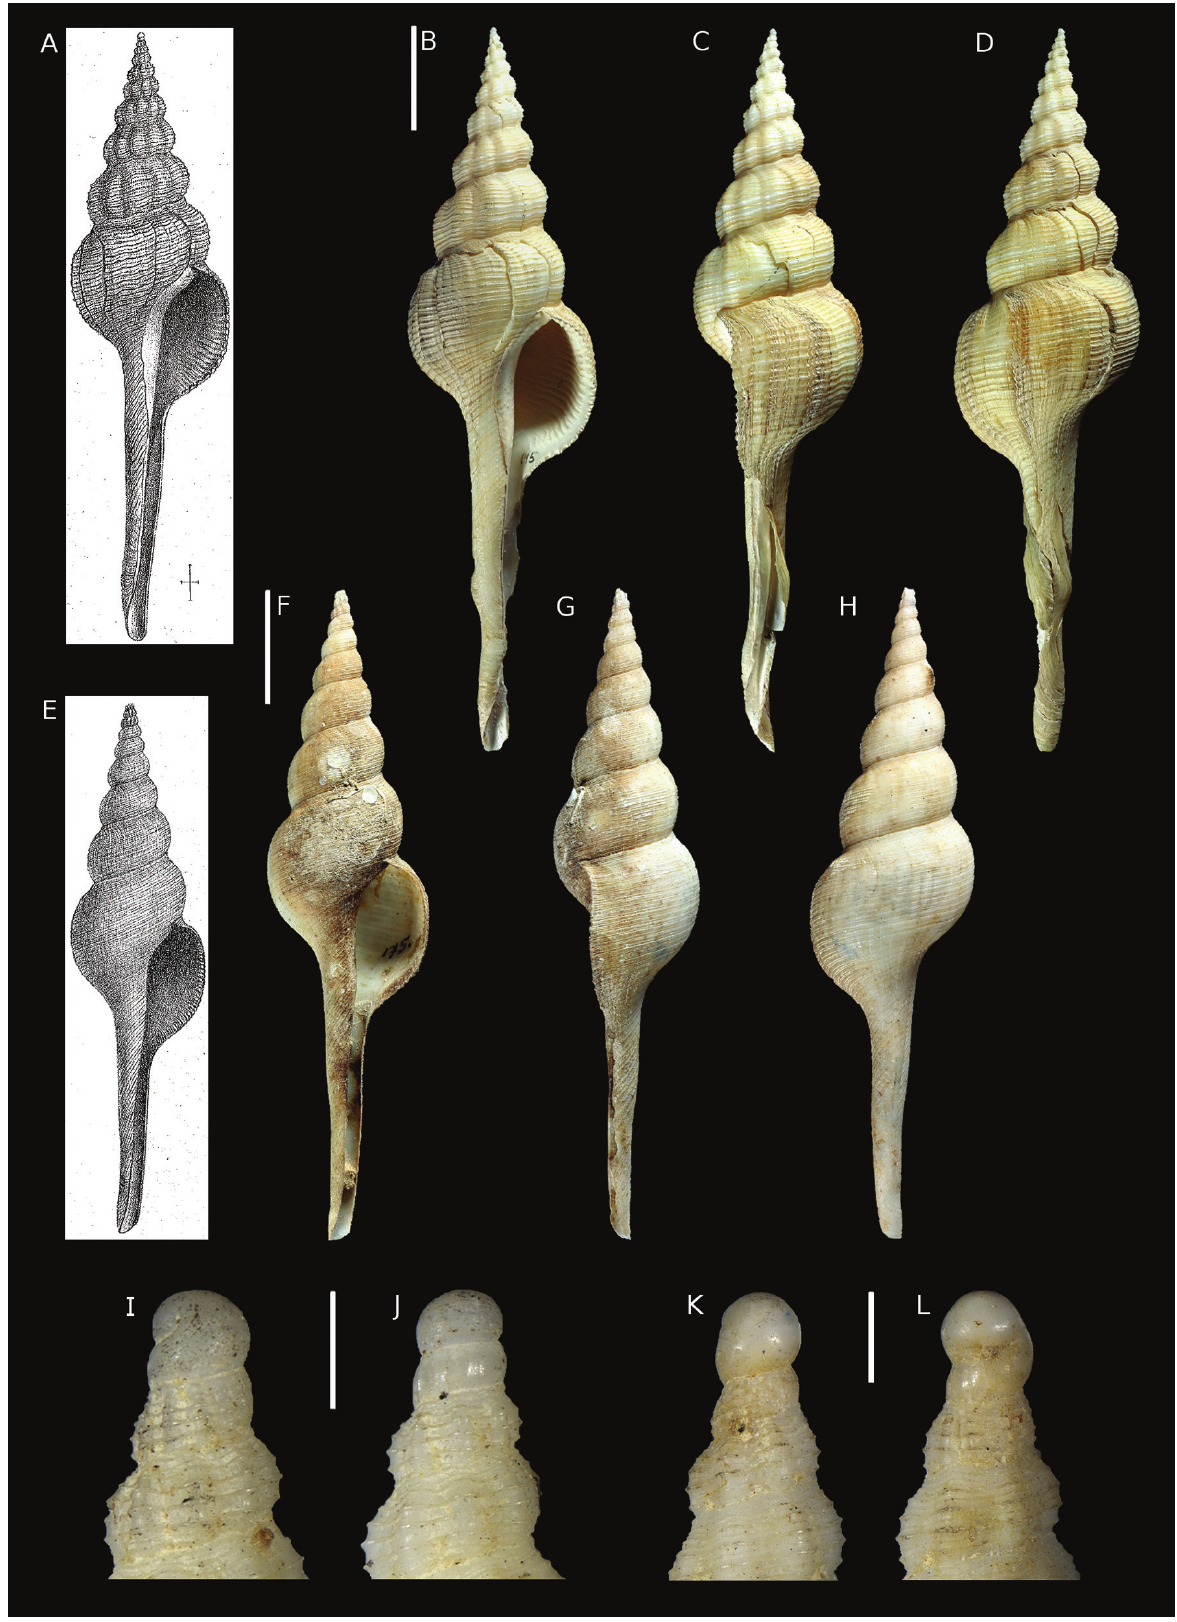
Figure 11. Fusus bifrons Sturany, 1900, Station 145 (east of Dahlak Island, Eritrea). A . Original figure of form typica by Sturany (1903). B–D, I–J . Figured syntype, NHMW 84147 (f. typica): front ( B ), right side ( C ), back ( D ), protoconch ( I–J ). E . Original figure of form paucicostata by Sturany (1903). F–H, K–L . Figured syntype, NHMW 84146 (f. paucicostata ): front ( F ), right side ( G ), back ( H ), protoconch ( K–L ). Scale bars: B–D, F–H : 20 mm; I–J, K–L : 0.2